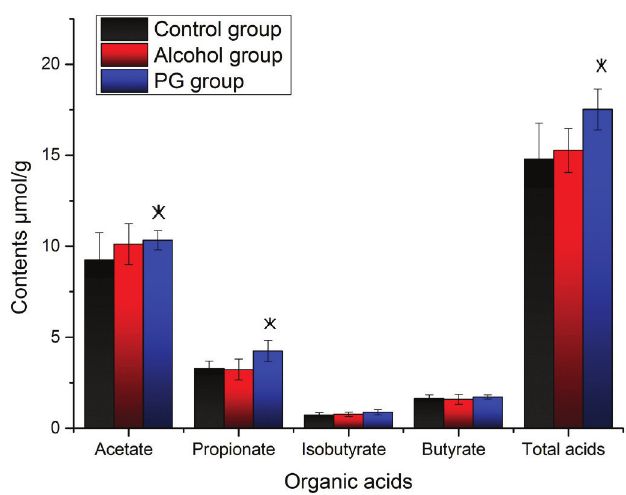
FIGURE 5 - Effect of PG on the accumulation of organic acids in the cecal of weaned rats.